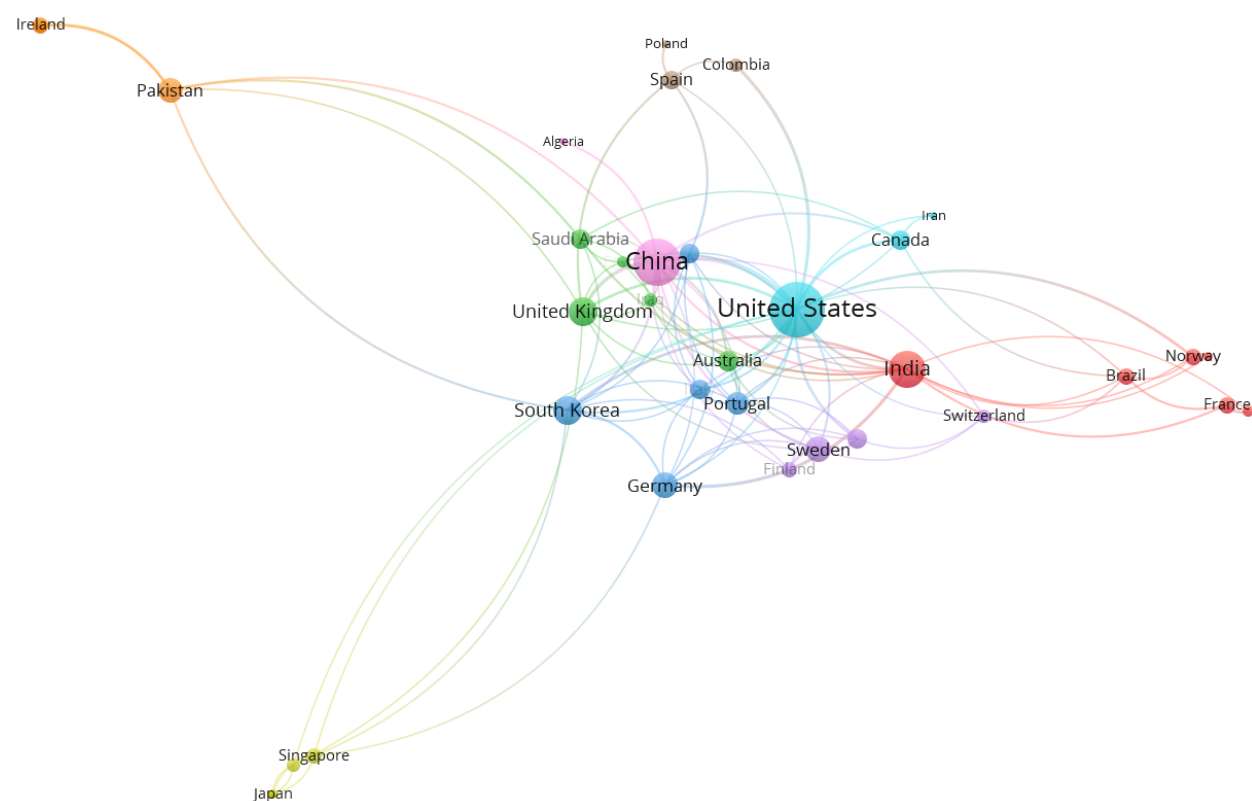
Figure 3. Co-authorship network visualization of countries in publication for 2014–2021.